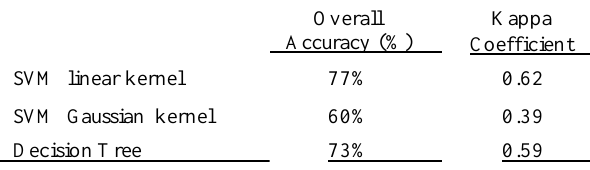
Table 2: Results of overall accuracy and kappa